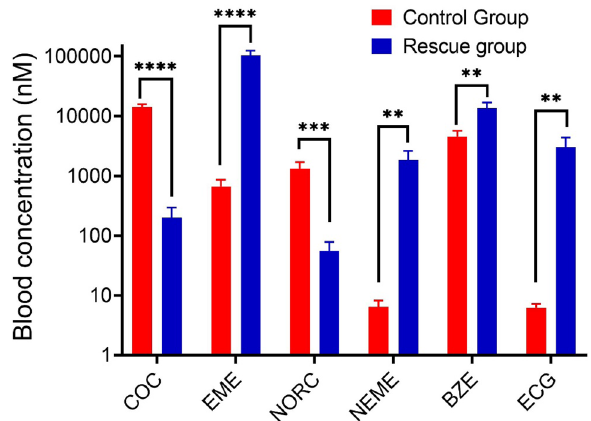
Figure 8. Blood concentrations of cocaine (COC) and its metabolites ( EME ecgonine methyl ester; NOC norcocaine; NEME norecgonine methyl ester; BZE benzoylecgonine; ECG ecgonine) after IP administration of 180 mg/kg cocaine in the control rats and CocH5-Fc(M6)-rescued rats (n = 4 per group) with enzyme administration after the onset of cocaine-induced convulsion ( i.e. 2–4 min after 180 mg/kg cocaine, IP). For the control rats, blood samples were collected at the time (~ 4 min) right after death (the red bars). For the CocH5- Fc(M6)-rescued rats, blood samples were collected at 10 min after IV administration of 1 mg/kg CocH5- Fc(M6). Statistical analysis ( t test using the GraphPad Prism 8.0 software): * p < 0.05; ** p < 0.01; *** p < 0.001; **** p <